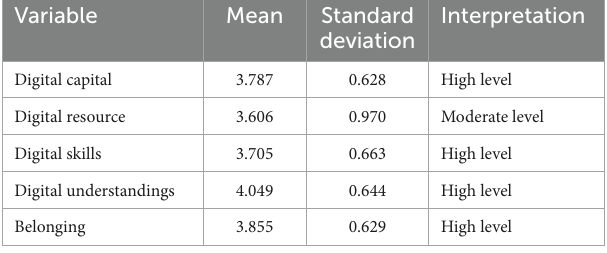
TABLE 2 Descriptive results on digital capital and